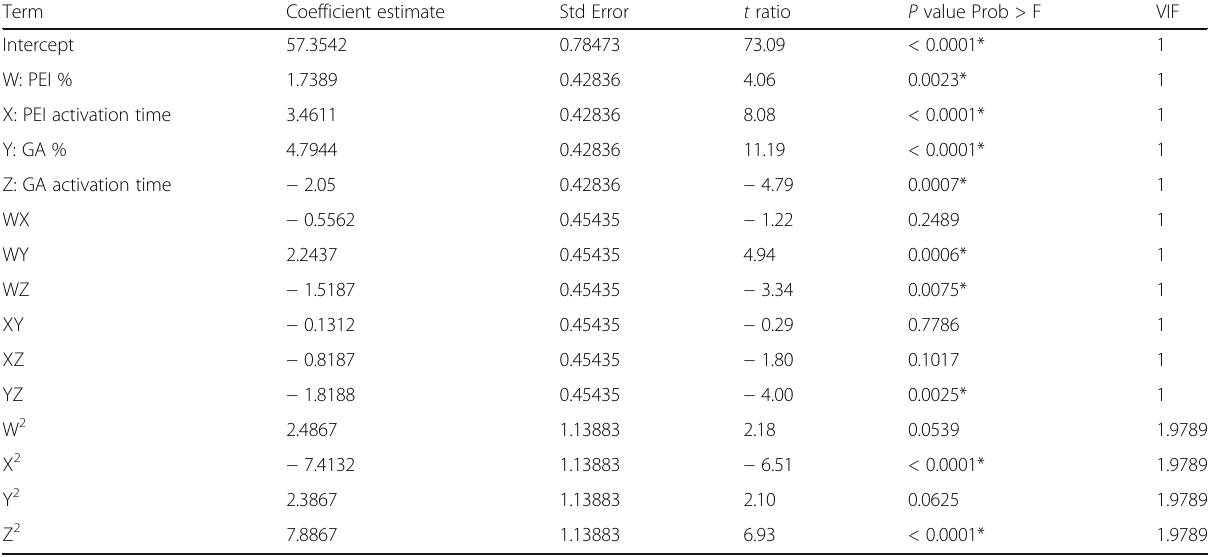
Table 3 Statistical analysis of CCD showing coefficients, t- values, P- values and standard errors Term